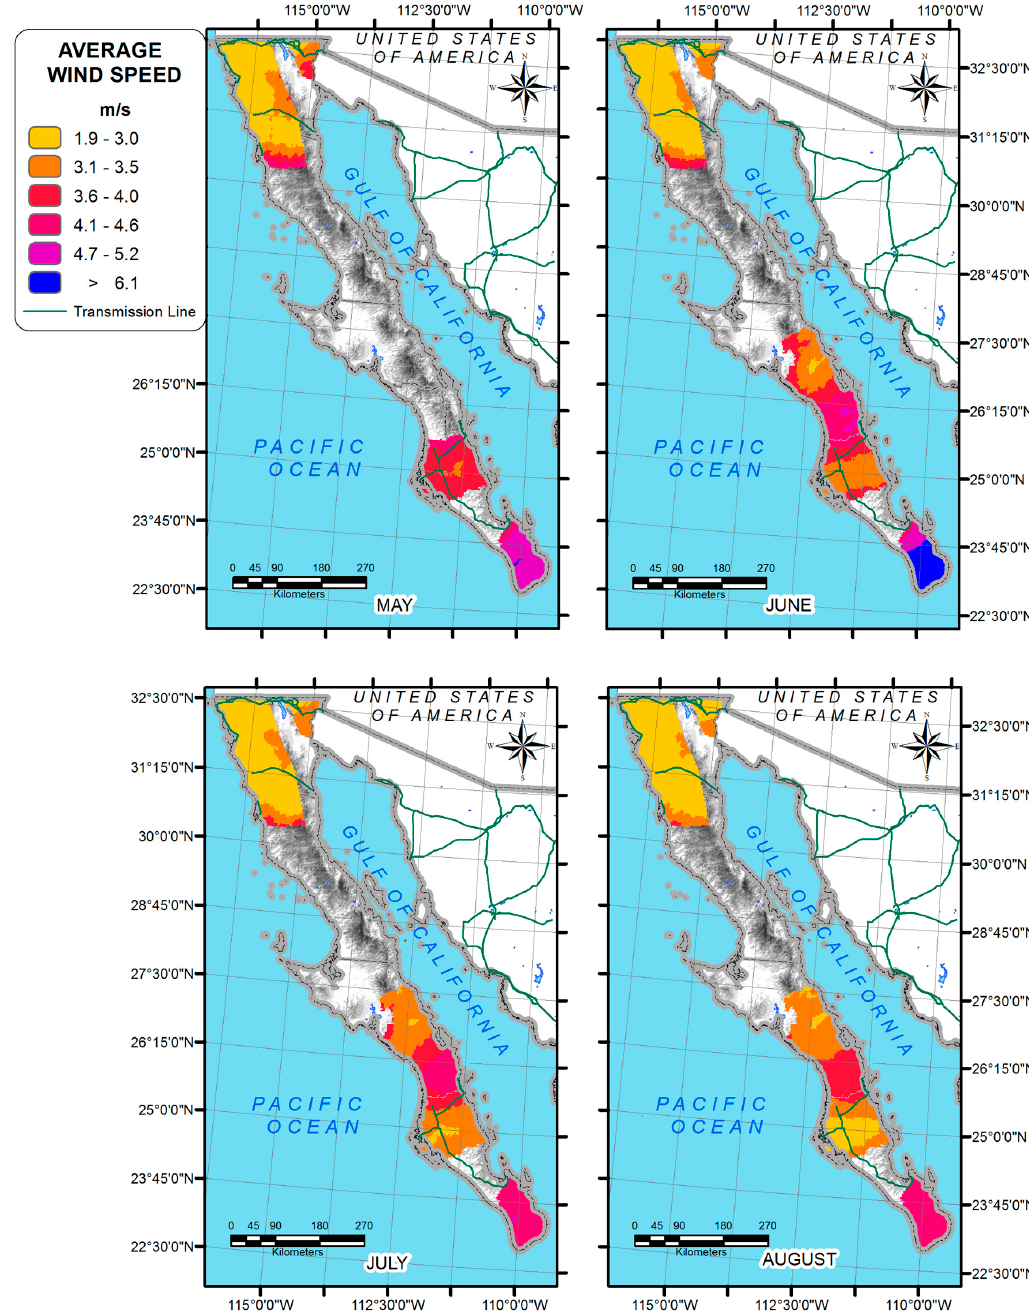
Figure 9. Average wind speed from May to August.